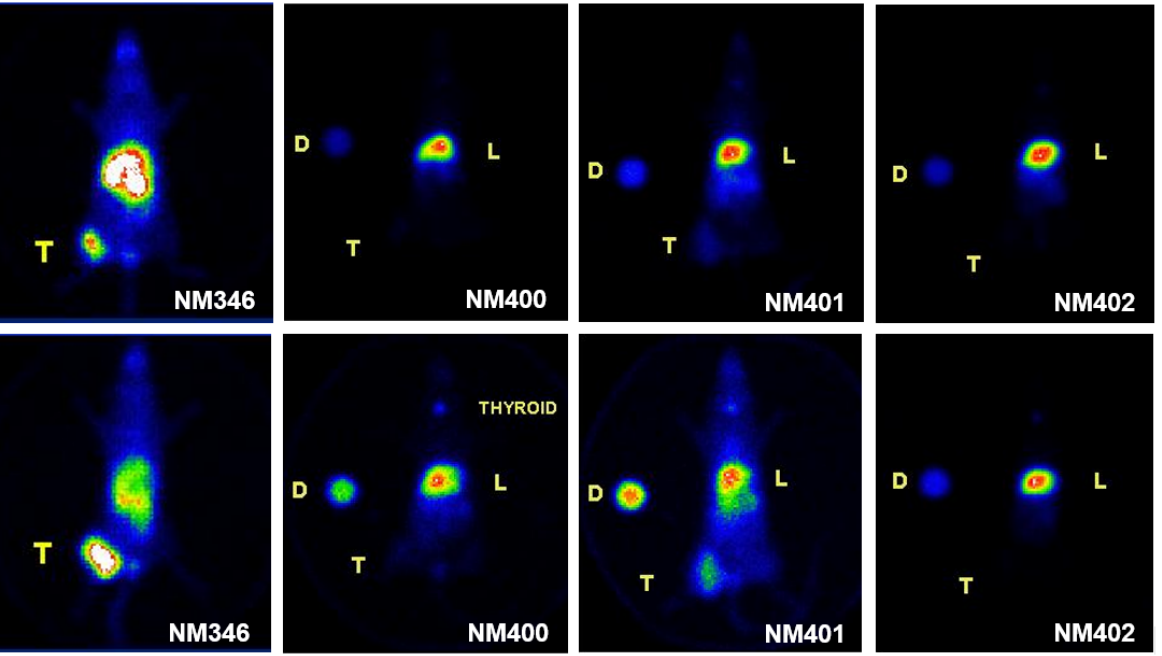
Figure 3. Representative gamma camera planer scans of rats bearing the Walker-256 carcinosarcoma at 24 h ( top row ) and 120 h ( bottom row ) following administration of iodine-125 labeled alkyl phospholipid polar head group analogs 1 (NM346), 2 (NM400), 3 (NM401) and 4 (NM402). L = liver and abdominal activity, D = dose standard, T = tumor.